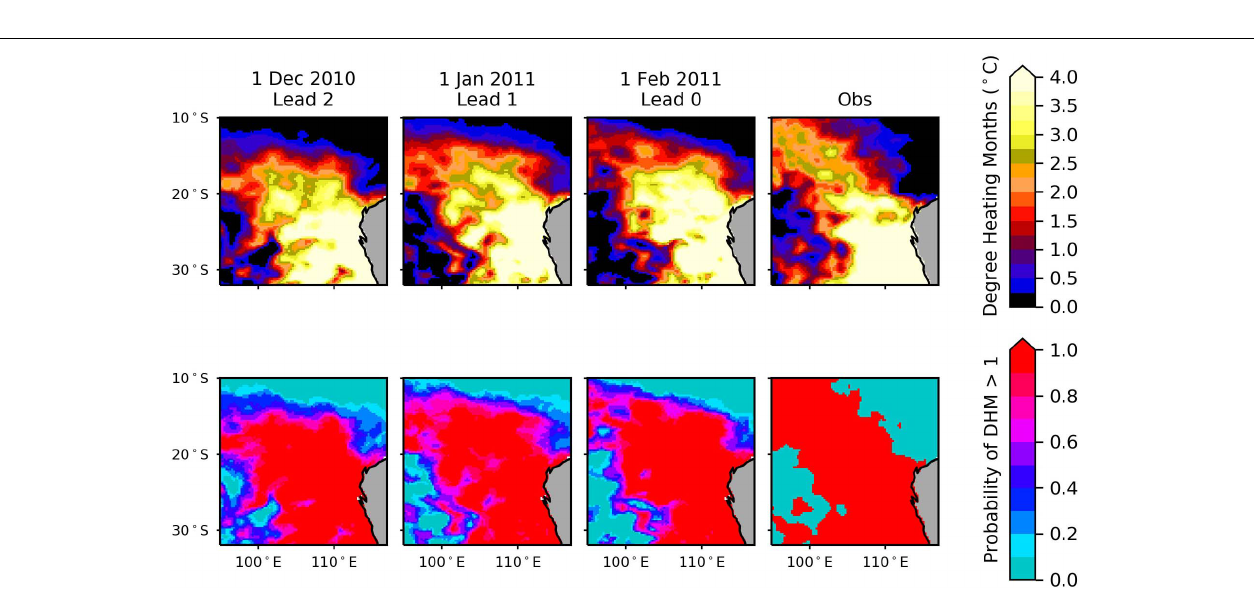
FIGURE 7 | Case Study 1: Hindcast DHM forecasts for Northern Australia for February to April 1998 for model start dates 1 December 1997, 1 January 1998, and 1 February 1998. Left column is ensemble mean DHM, right column is probability of DHM > 1, using 22 ensemble members. Observed DHM values for February to April 1998 are shown in the bottom row.